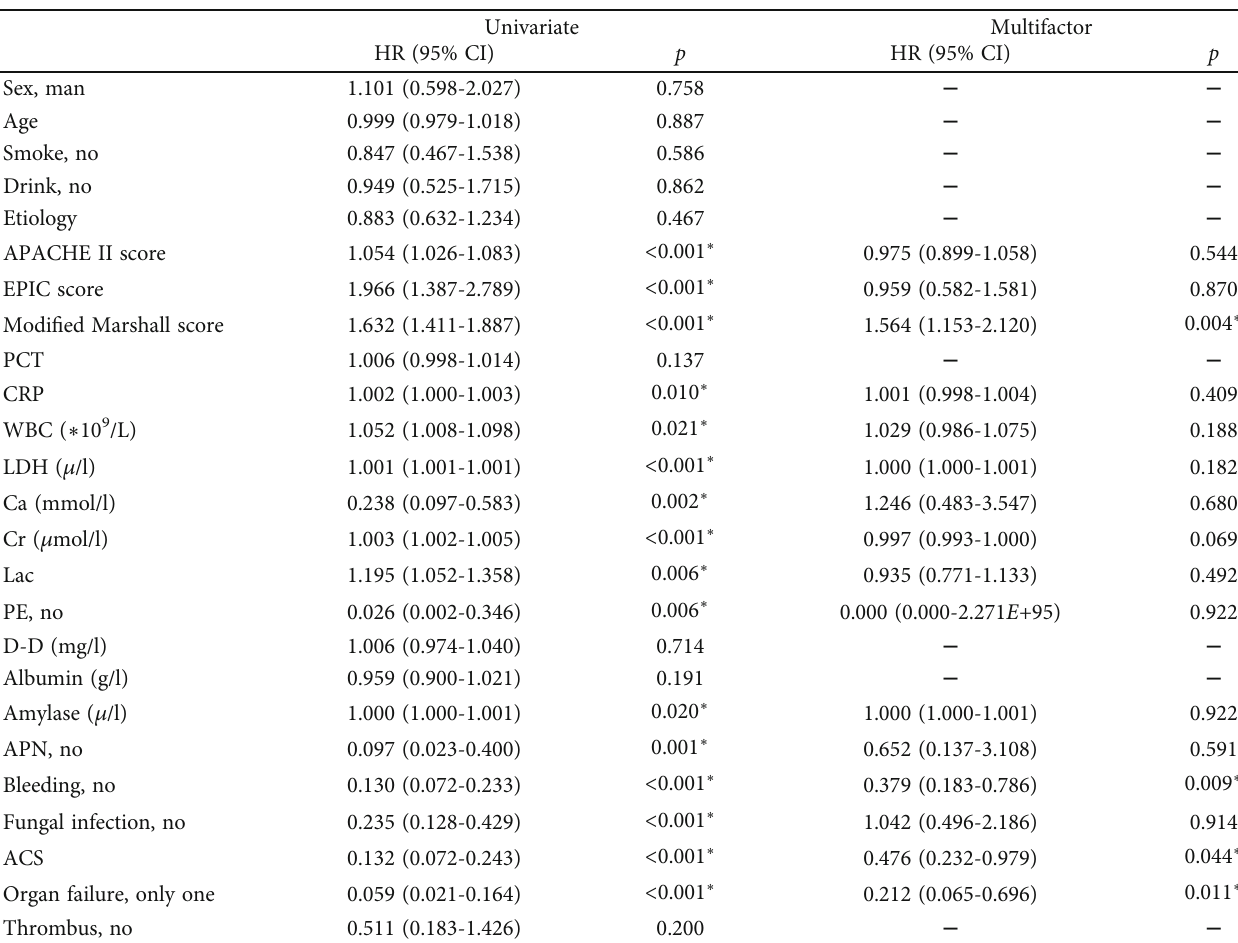
Table 2: Univariate and multifactor analysis of Cox regression model in